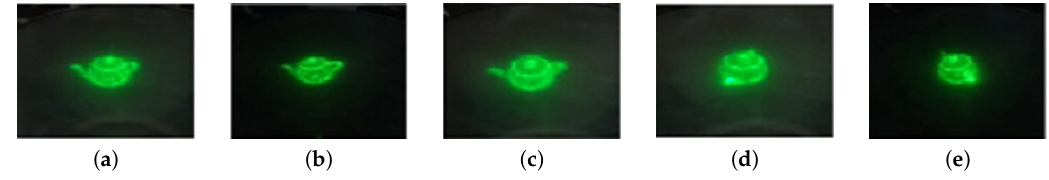
Figure 11. Result of basic rotation gestures. ( a ) Default state; ( b ) Up; ( c ) Down; ( d ) Right; ( e )